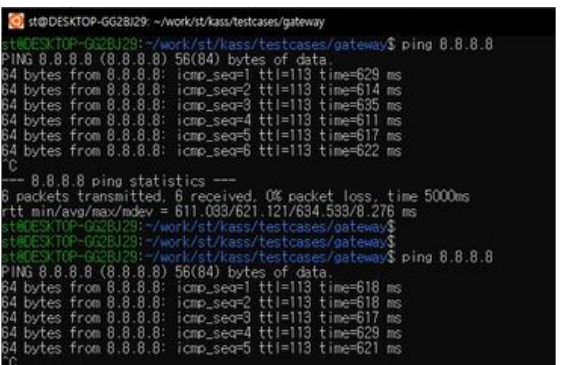
Figure 17. Round trip time measured from VSAT end-device at KTSAT Kumsan satellite service center, in Kumsan, Republic of Korea.